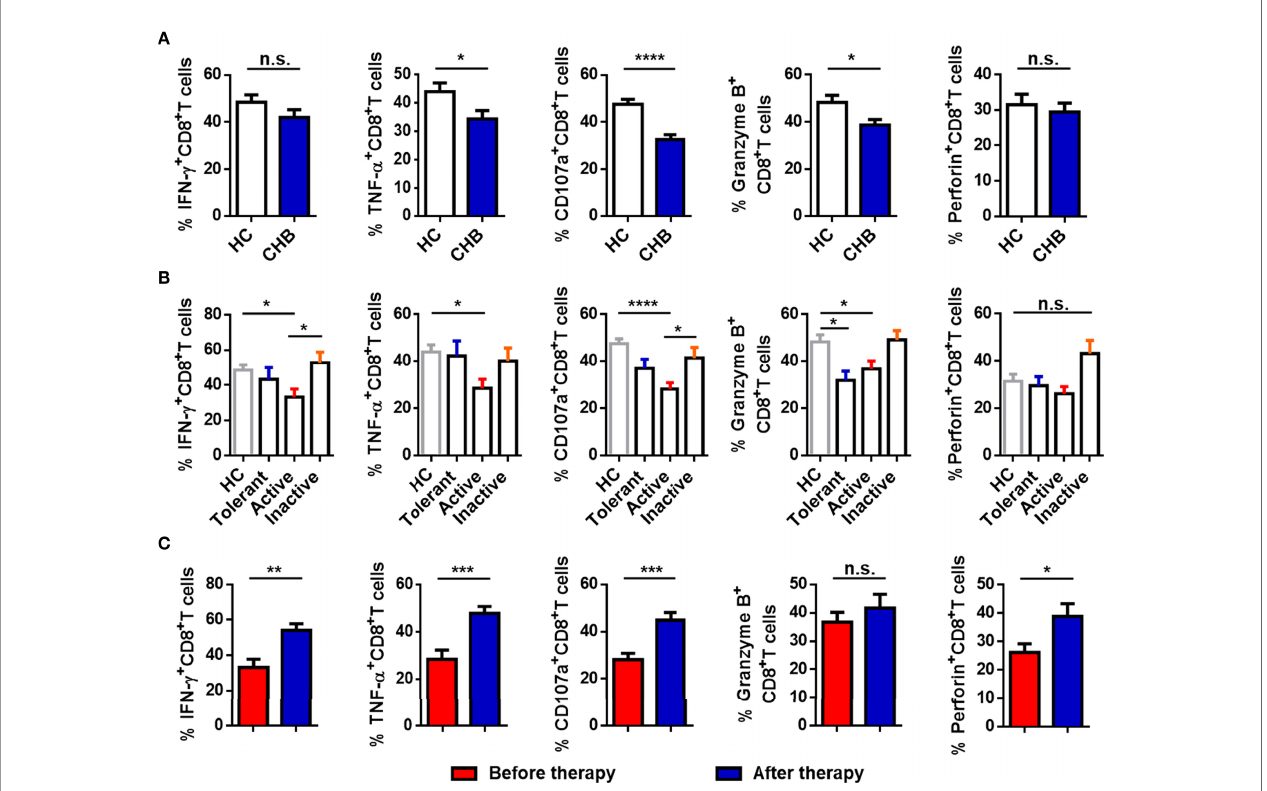
FIGURE 3 | CD8 + T cells are functionally exhausted in active CHB patients. (A) Comparison of the expression of IFN- g , TNF- a , CD107a, granzyme B, and perforin in circulating CD8 + T cells from CHB patients and HCs. (B) Comparison of the expression of IFN- g , TNF- a , CD107a, granzyme B, and perforin in circulating CD8 + T cells from Tolerant, Active, and Inactive CHB patients and HCs. (C) Comparison of the percentages of functional molecules, including IFN- g , TNF- a , CD107a, granzyme B, and perforin, in circulating CD8 + T cells from the untreated and treated CHB patients. Results are expressed as the mean ± SEM, and the number of samples (n) in each group was ≥ 3. One-way ANOVA test was conducted for four-group comparisons. Groups with signi fi cant differences are marked, and the unmarked paired groups have no differences. An unpaired t-test was used to compare two independent groups. *P < 0.05; **P < 0.01; ***P < 0.001; ****P < 0.0001; n.s., not signi fi